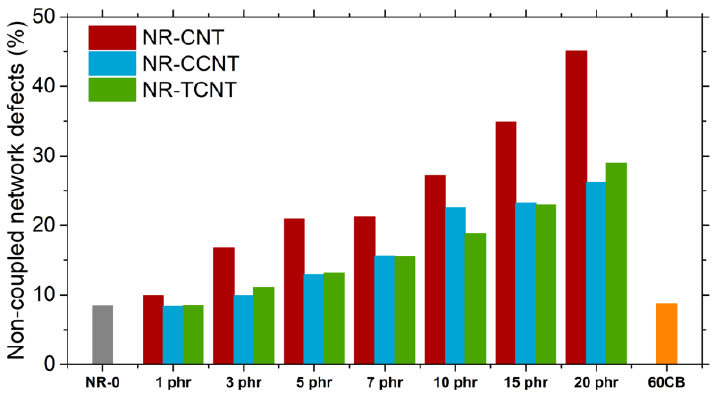
Figure 20. Non-coupled network defects of NR/CNT, NR/CCNT, and NR/TCNT compounds.